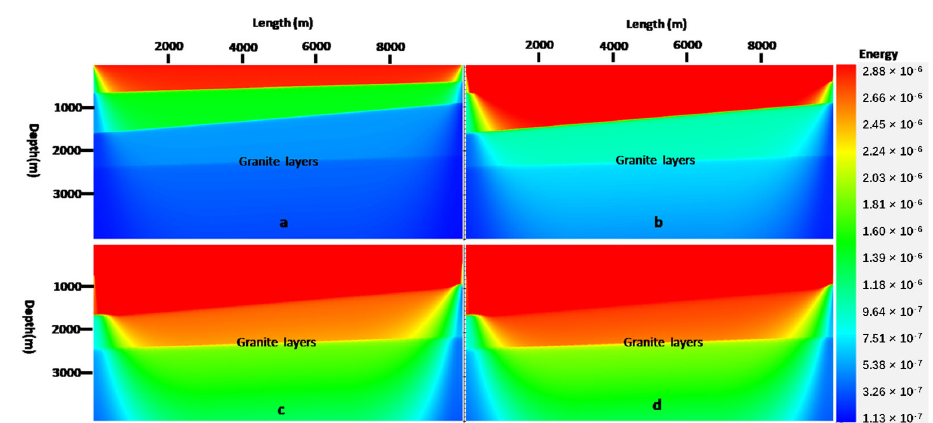
Energies 2023 , 16 , x FOR PEER REVIEW 12 of 16 Figure 9. Comparison of the illumination effects of the data acquired from the HDR using different folds (( a ): 200 folds, ( b ): 400 folds, ( c ): 600 folds and ( d ): 800 folds).